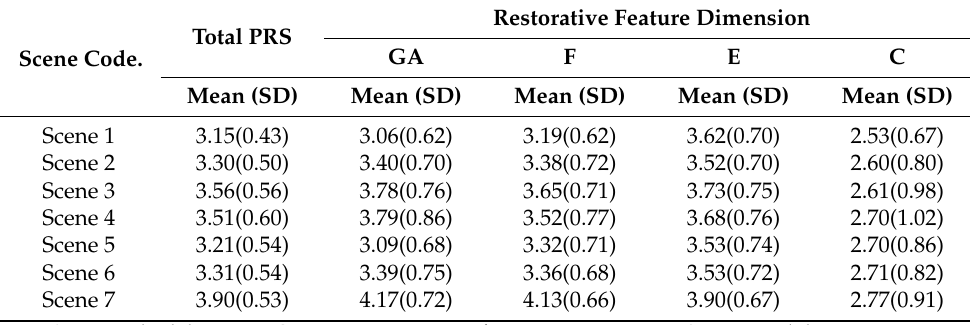
Table 2. Mean RPRS values and standard deviations for all spatial scenes.